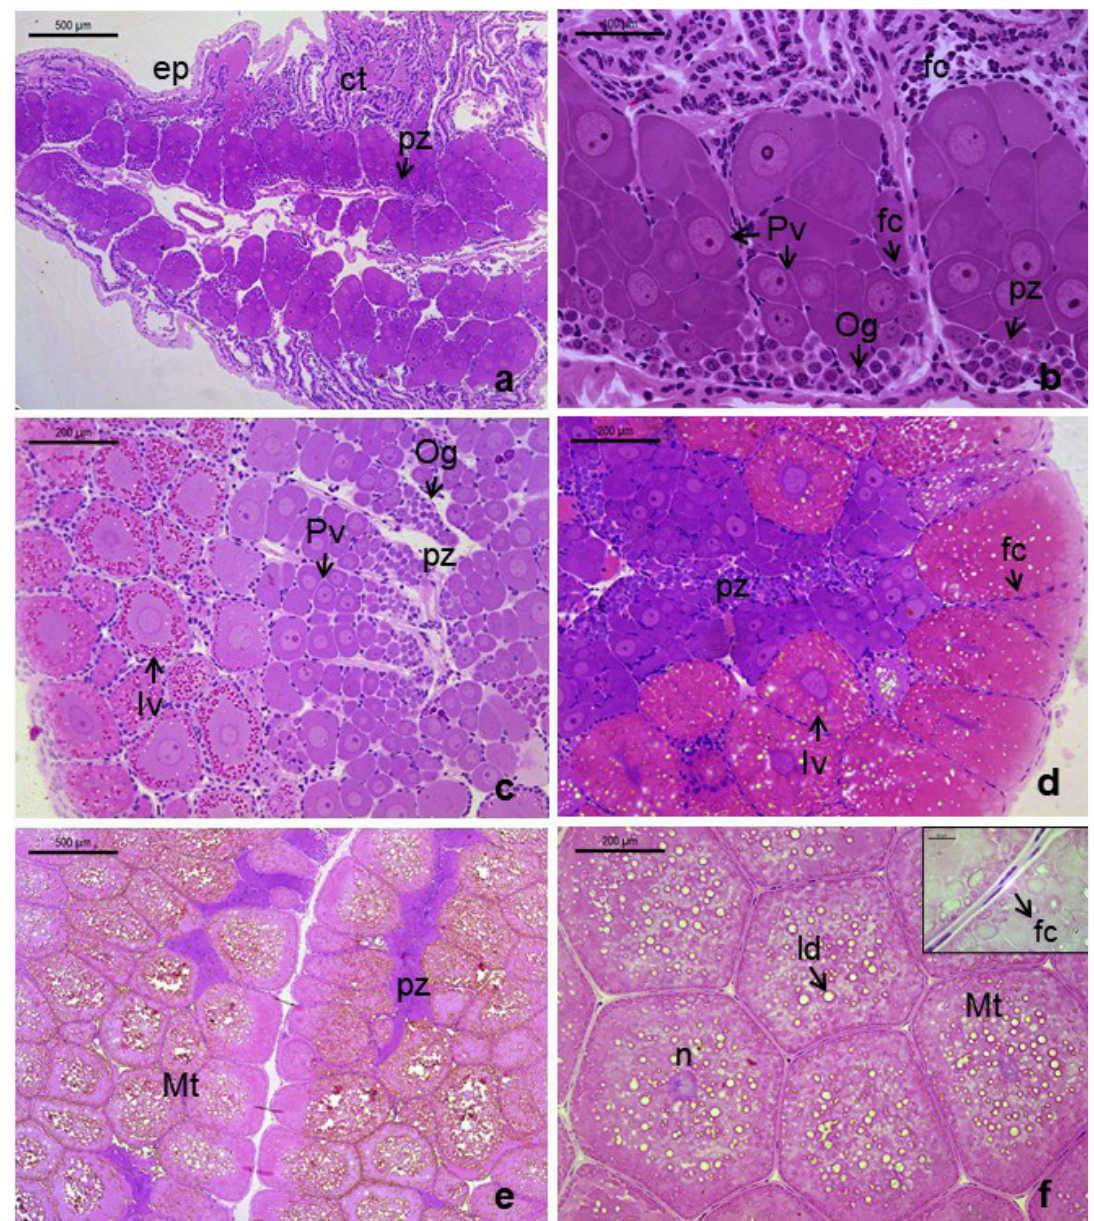
Figure 2. Histological sections of the ovaries of Macrobrachium acanthurus . a) Spent ovaries, note the disorganized ovary with ovarian epithelial tissue with much connective tissue and most oocytes in early vitellogenesis; b) Detail of spent oocyte; c) In maturation ovaries, evolution of the oocytes from inside out, in the middle region is the proliferative zone (oogonia and previtellogenic oocytes); there are oocytes in vitellogenesis concentrating yolk granules in the peripheral region; d) Detail of a in maturation gonad showing follicular cells involving oocytes in vitellogenesis that have large accumulation of yolk granules and a still visible nucleus; e) Mature ovaries, showing a small zone of proliferation and predominance of oocytes in final vitellogenesis (Developed); f) Mature ovaries, note that the mature oocytes are hexaedra-shaped with small nucleus and many lipid droplets, and are surrounded by flat-shaped follicular cells. Staining: Hematoxylin-eosin; Connective tissue - ct; epithelial tissue - ep; follicular cells - fc; oocyte in vitellogenesis - Iv; mature oocytes- Mt; lipid droplet- ld; nucleus - n; oogonia - Og; previtellogenic oocyte - Pv; proliferative zone - pz. 4x (a, e), 10x (c, d, f), 20x (b), 100x